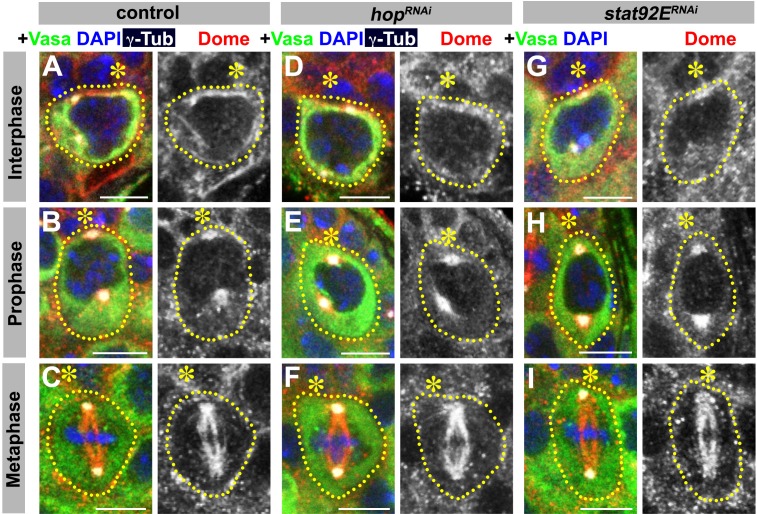
JAK or STAT is not required for correct Dome localization.(A–C) Examples of Dome staining in control interphase (A), prophase (B) and metaphase (C) GSCs. (D–F) Examples of Dome staining in nos-gal4ΔVP16, gal80ts > UAS-hopRNAi interphase (D), prophase (E) and metaphase (F) GSCs. (G–I) Examples of Dome staining in nos-gal4ΔVP16, gal80ts > UAS-stat92ERNAi interphase (G), prophase (H) and metaphase (I) GSCs. Asterisk indicates the hub. Green: Vasa. Red: Dome. White: γ-Tubulin. Blue: DAPI. Bar: 5 μm.